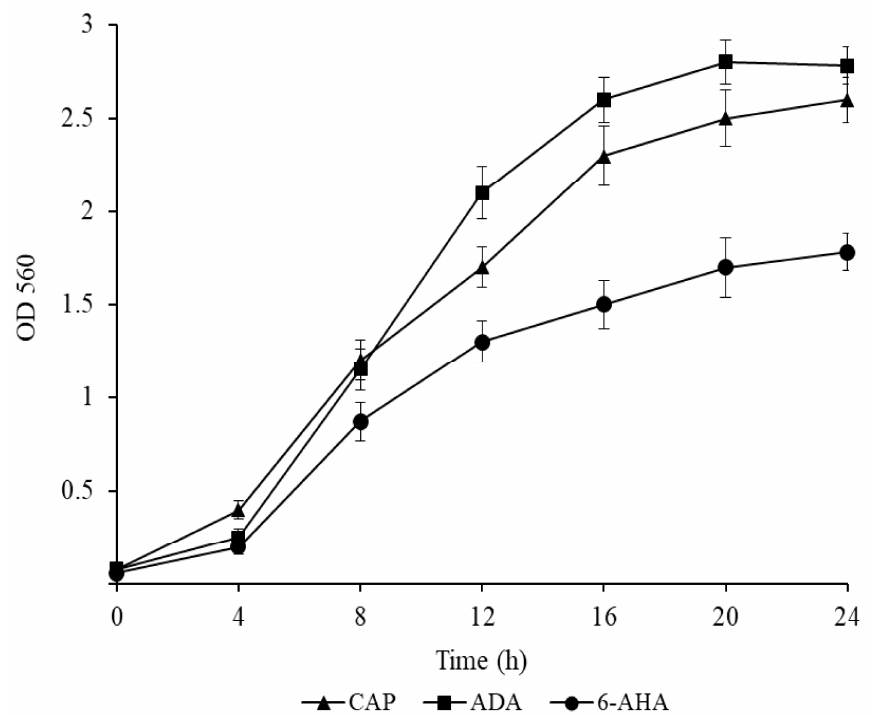
Figure 1. Growth dynamics of P. putida strain Ch2 in liquid mineral medium M9 containing caprolactam (CAP), adipic acid (ADA) and 6-aminohexanoic acid (6-AHA) as sole carbon and energy sources. The substrates were used at a concentration of 1.0 g/L. The designation 6-AHA is lost in the legend of the figure. The correct picture was inserted into the cover letter. Please correct.